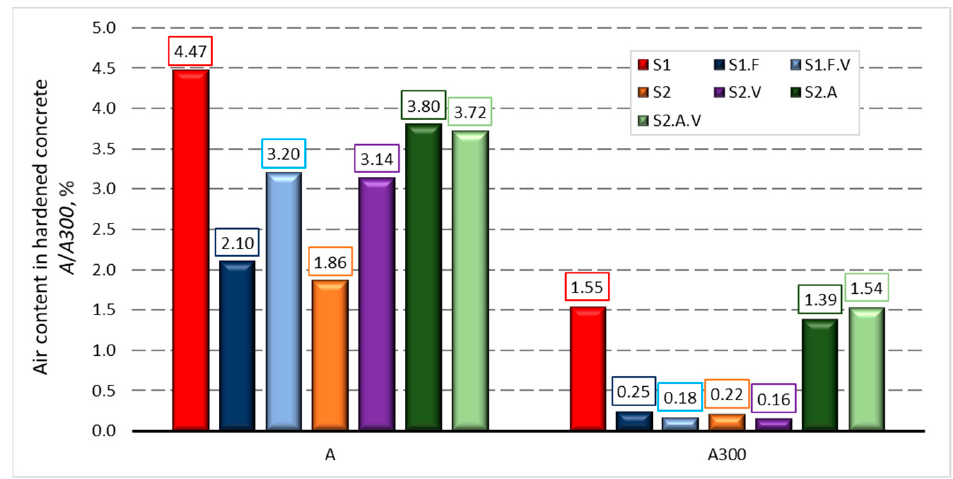
Figure 3. Results of measurements of the total volume of air voids, A , and the volume of voids, A300 , with a diameter less than 300 μ m in hardened concrete after 28 days of curing.